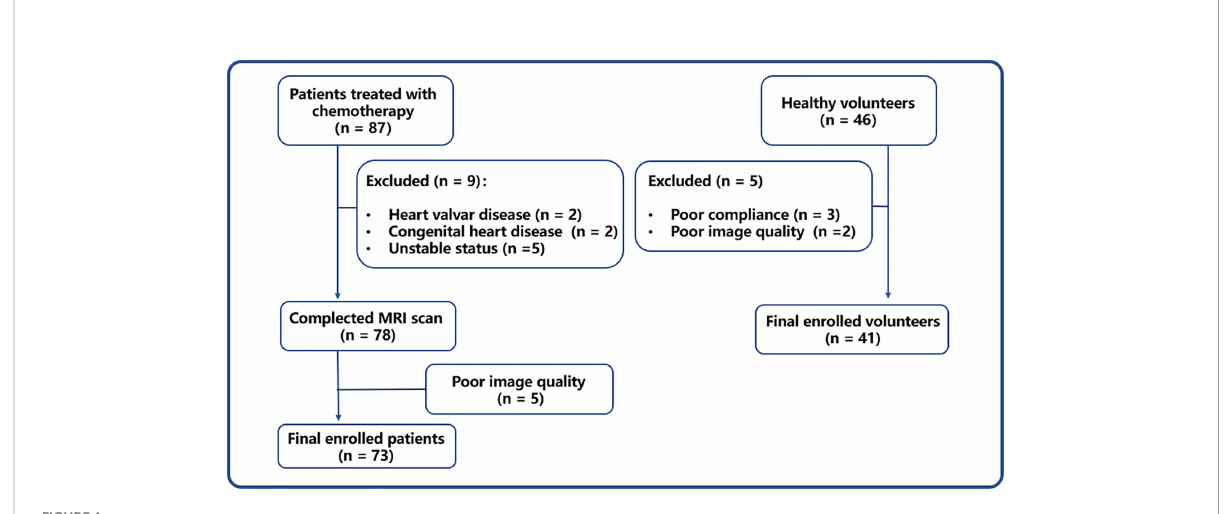
FIGURE 1 Study fl owchart. CMR, cardiac magnetic